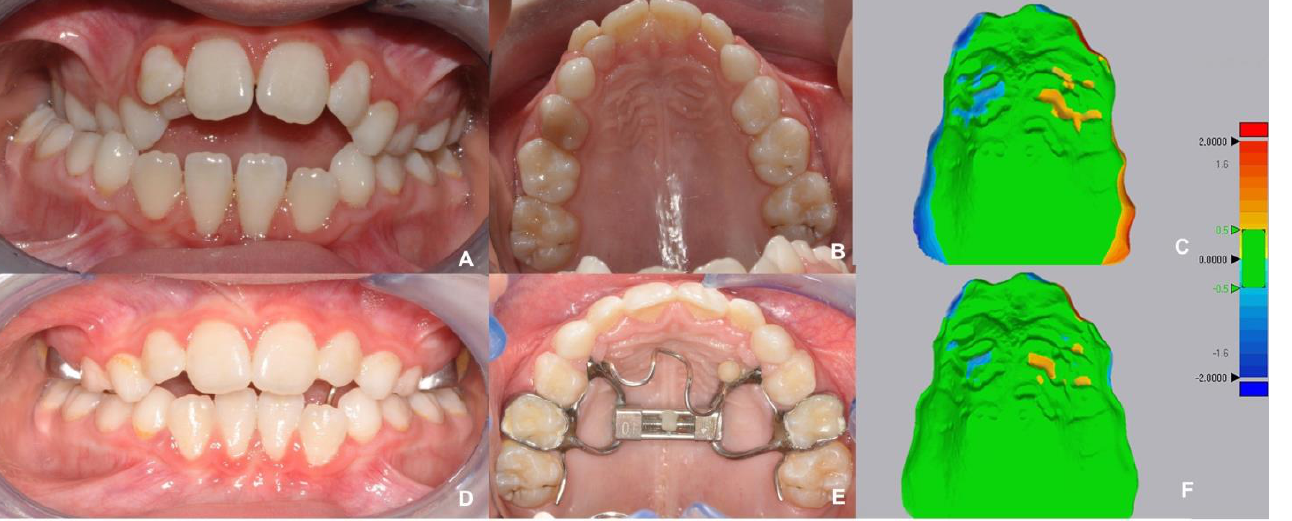
Figure 9. Example of computer-assisted analysis of maxillary asymmetry using reverse engineering software. In this 7-year-old girl, there was a significant improvement of maxillary symmetry (blue-colored and red-colored areas) after treatment with maxillary expander. ( A ), Pre-treatment frontal view; ( B ), pre-treatment occlusal view; ( C ), pre-treatment deviation analysis between original maxillary scan and mirrored scan; ( D ), post-treatment frontal view, ( E ), post-treatment occlusal view; ( F ), post-treatment deviation analysis between original maxillary scan and mirrored scan.